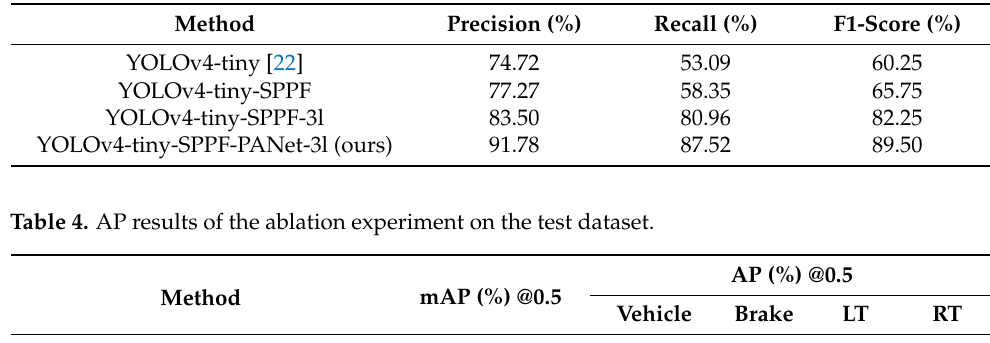
Table 3. Precision, recall, and F1-score results of the ablation experiment on the test dataset.